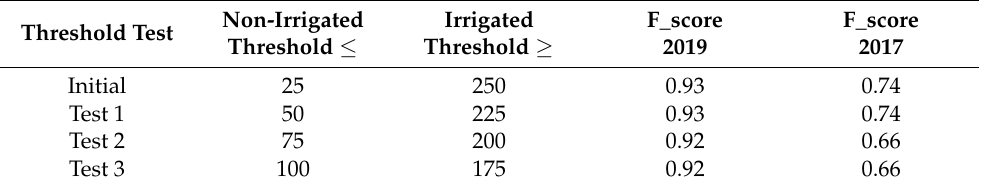
Table 5. Variation of obtained weighted F_score as a function of the threshold values of cumul ipw for 2017 and